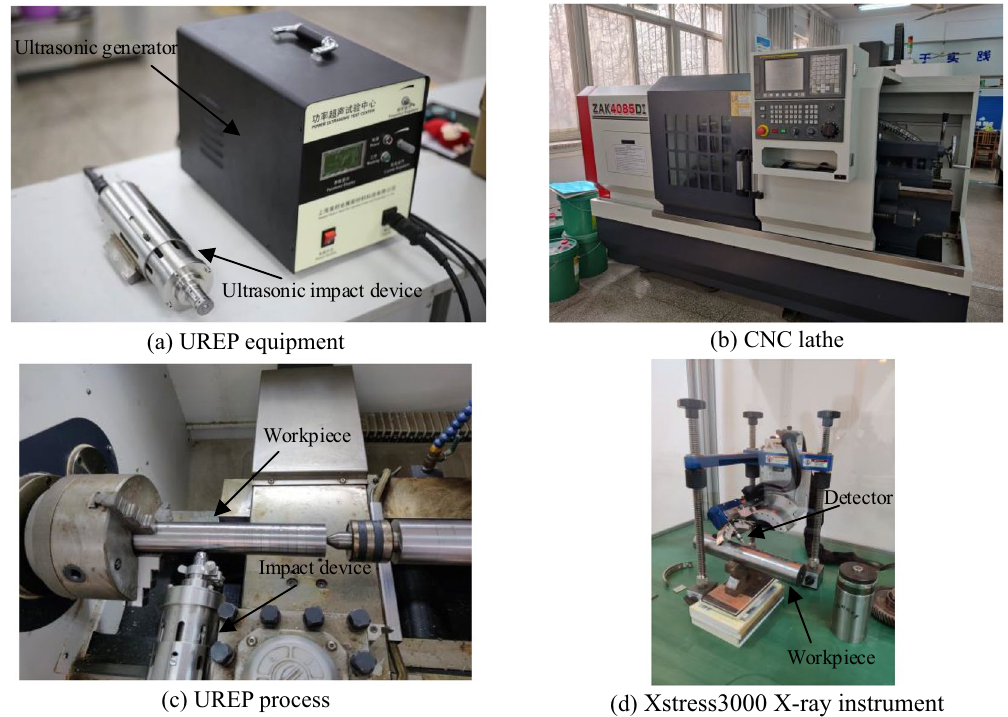
Figure 4. UREP machining